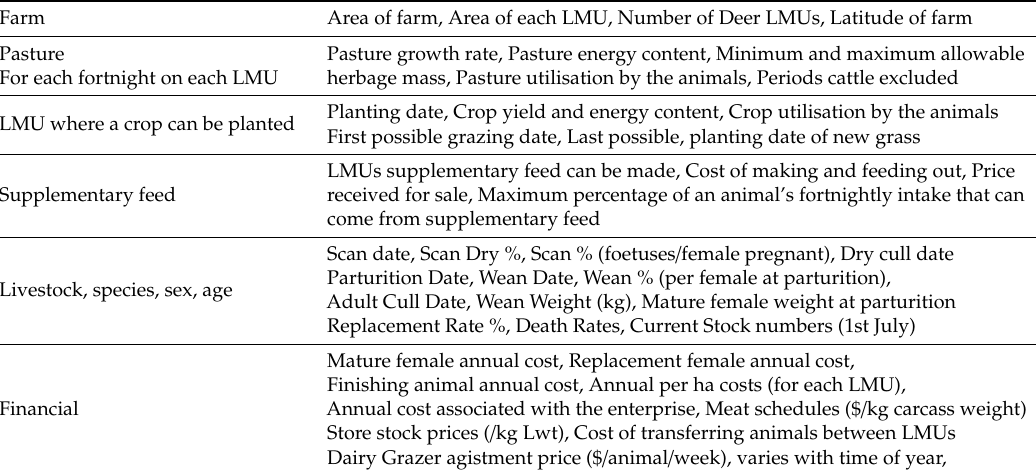
Table 1. Inputs required for AgInform ®